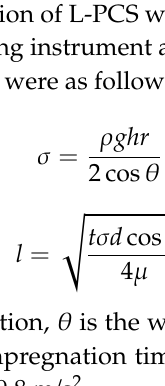
Figure 5. PCS viscosity variation under 80 r/min rates after 3 h under ( a ) heating treatment and ( b ) acetone introduction.